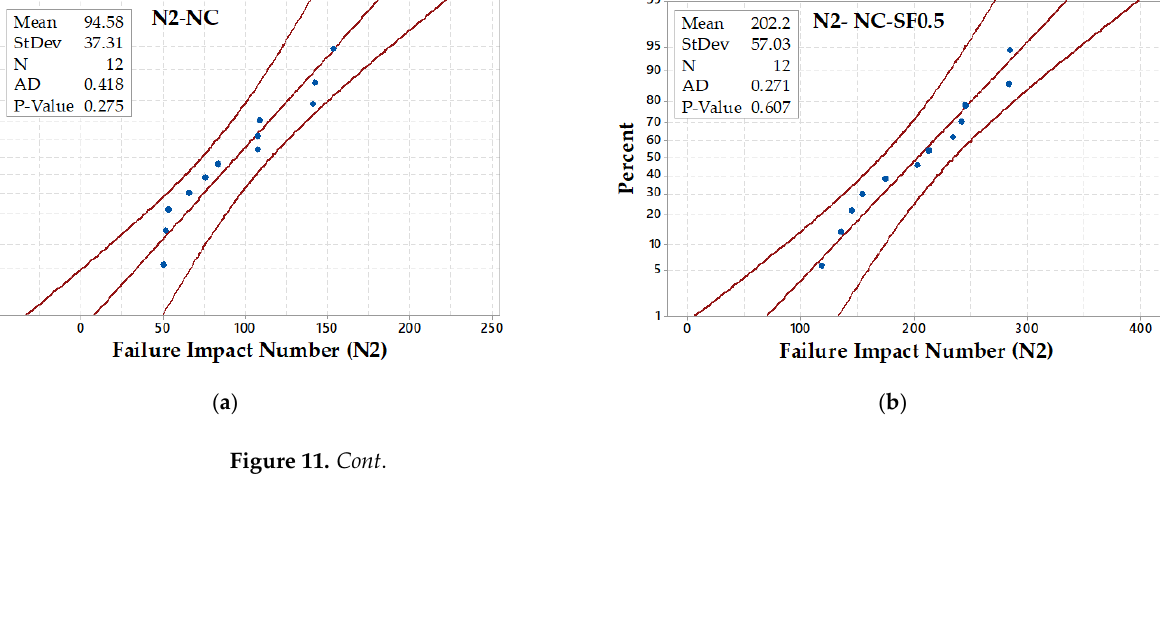
Figure 11. Normal probability plots of the results at the failure stage for mixtures ( a ) NC ( b ) NC-SF0.5 ( c ) NC-SF1.0 and ( d ) HC. 5. Weibull Distribution During the preliminary phases of the investigation into the impact strength of con- crete, scientists discovered that the ACI 544-2R repeated drop-weight test was distinct. Despite the significant amount of work put into creating equal testing settings, the find- ings of the tests were clearly distinguishable. As a result, statistical analysis seemed nec-